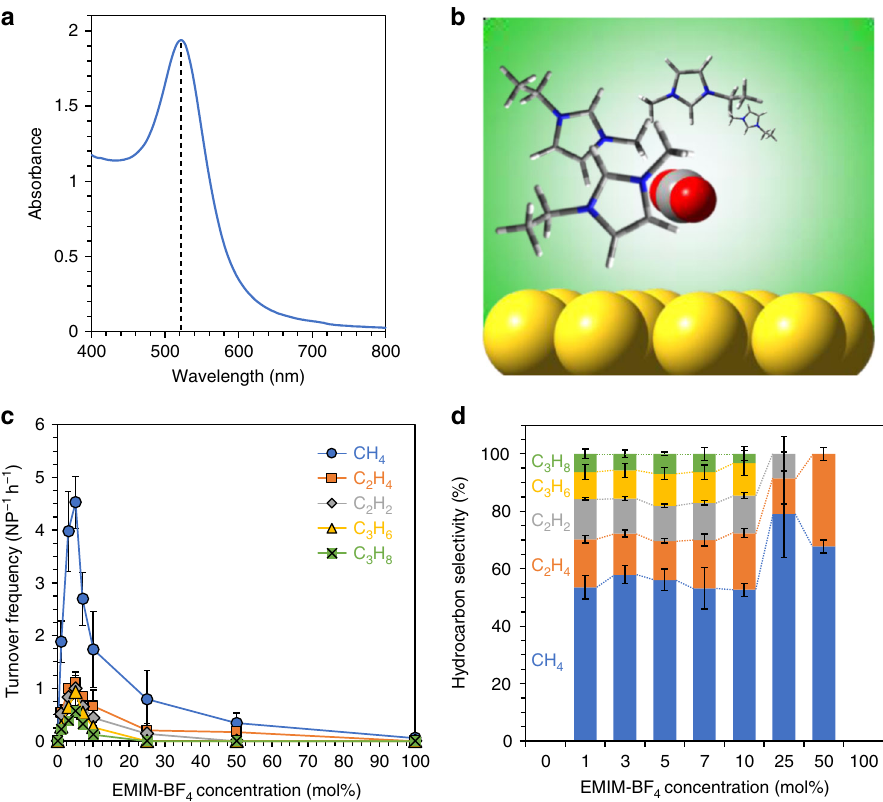
Fig. 1 Ionic-liquid-promoted CO 2 reduction to C 1 – C 3 hydrocarbons using a plasmonic Au nanoparticle (NP) photocatalyst. a UV − vis extinction spectrum of a colloid of the Au NPs used for preparation of the photocatalyst fi lm. The spectrum exhibits a localized surface plasmon resonance (LSPR) band centered around 520 nm, as indicated by the dotted line. b Scheme for CO 2 conversion on plasmon-excited Au NPs promoted by an ionic liquid, EMIM-BF 4 . A continuous-wave (CW) laser of a wavelength of 532 nm and intensity of 1 W cm – 2 was used as the light source for photoexcitation of Au NPs. EMIM-BF 4 stabilizes CO 2 and resulting adsorbates/intermediates on the photoexcited Au surface. c Turnover frequencies of hydrocarbon products formed in the CO 2 RR plotted as a function of the EMIM-BF 4 concentration (mol%). The CO 2 conversion activity peaks at 5 mol% of EMIM-BF 4 . d Hydrocarbon product selectivity as a function of EMIM-BF 4 concentration (mol%). Each data point in c and d is the average of results from three identical trials and the error bar represents the SD of these